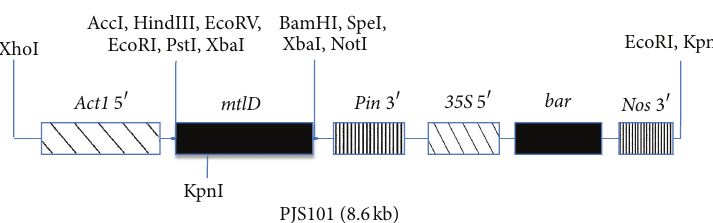
Figure 2: The linear map of JS101 construct. The bacterial mtlD gene driven by rice actin promoter ( Act1 5 󸀠 ) and potato protease inhibitorII terminator ( pinII 󸀠 ), and the bar selectable marker gene regulated by the cauliflower mosaic virus ( 35S ) promoter and Nos 3 󸀠